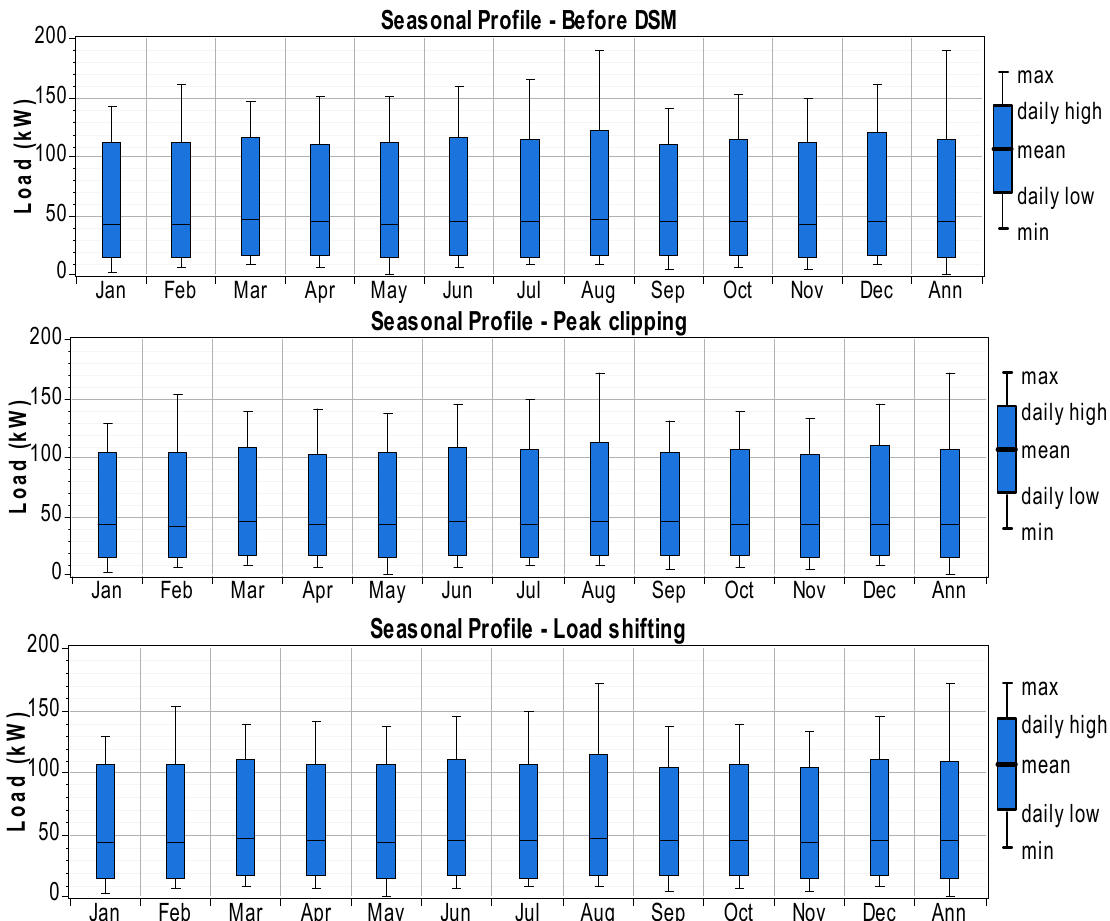
Figure 8. Seasonal profile before and after DSM using HOMER. Table 7. Comparison of average load, peak load, and electricity bill (EB) reduction–before and after DSM. Description